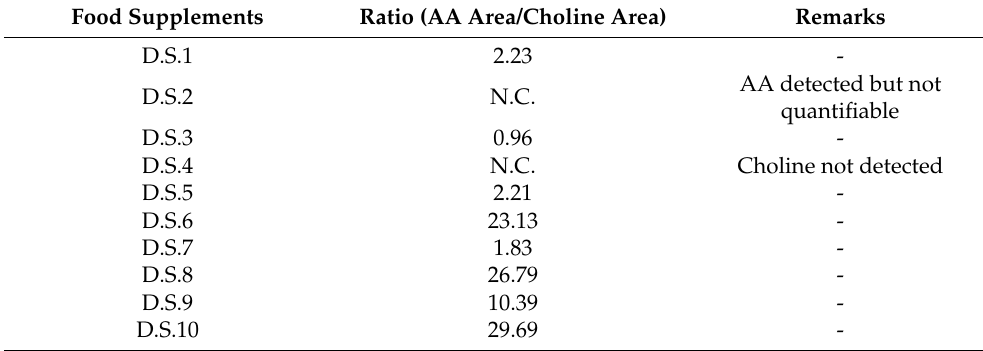
Table 2. Calculated ratio (AA area/choline area) for 1 H-NMR spectra from food supplements. Food